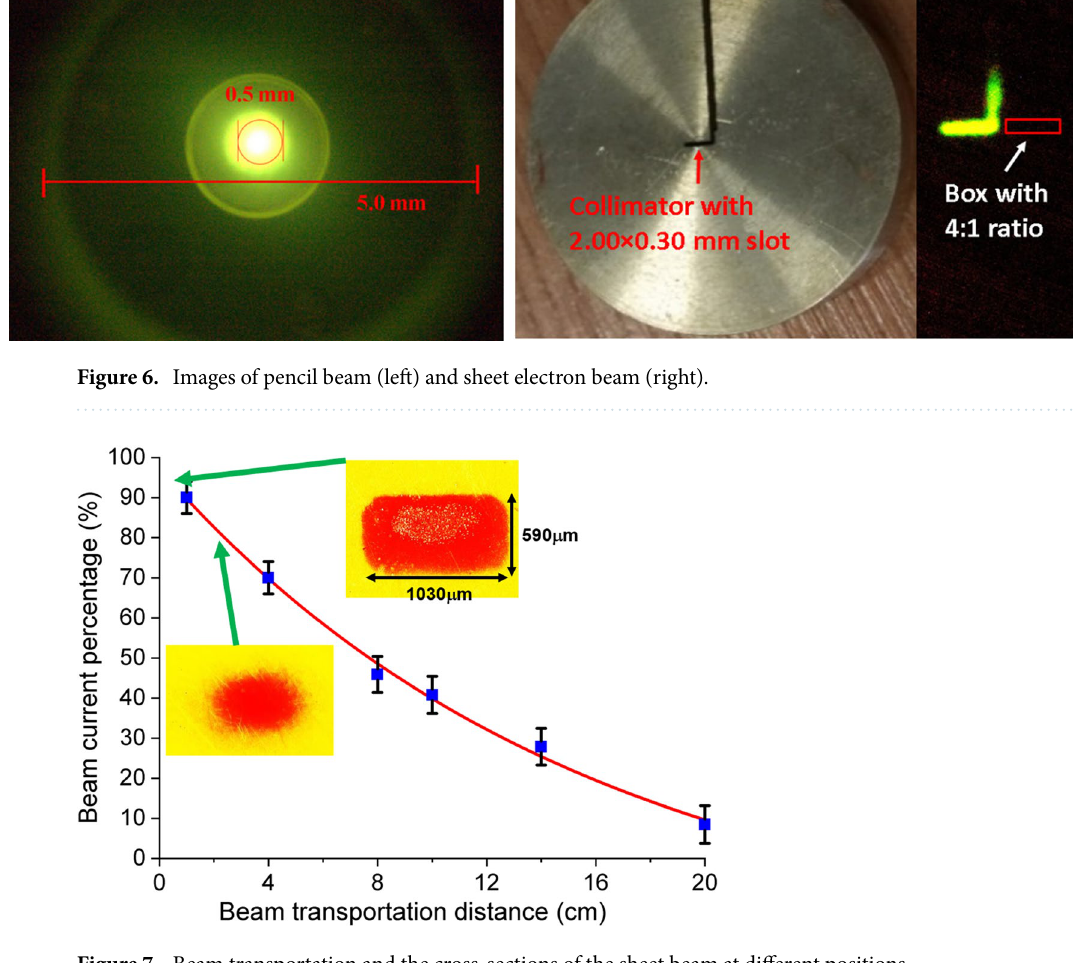
Figure 7. Beam transportation and the cross-sections of the sheet beam at different